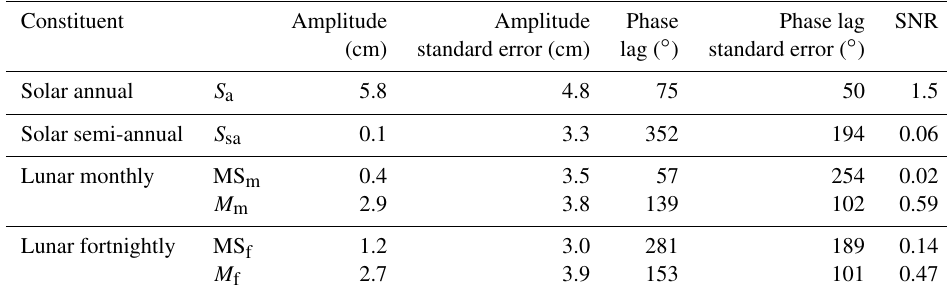
Table 2. Harmonic constants for six long-period tidal constituents, derived from harmonic analysis of a 1-year-long observation (2013) measured at the ROBT sea level gauge, using T_TIDE (Pawlowicz et al., 2002). Note that this gauge is a vented piezometer so caution should be exercised in interpreting the results (particularly for S a and S sa ) given the inclusion of proportionately large non-tidal (atmospheric) variations in this kind of sea level record. Constituent Amplitude Amplitude Phase Phase lag